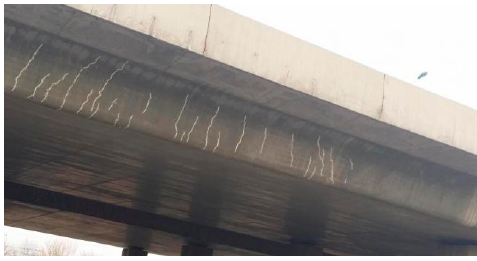
Figure 1. Schematic diagram of T-beam cracks.